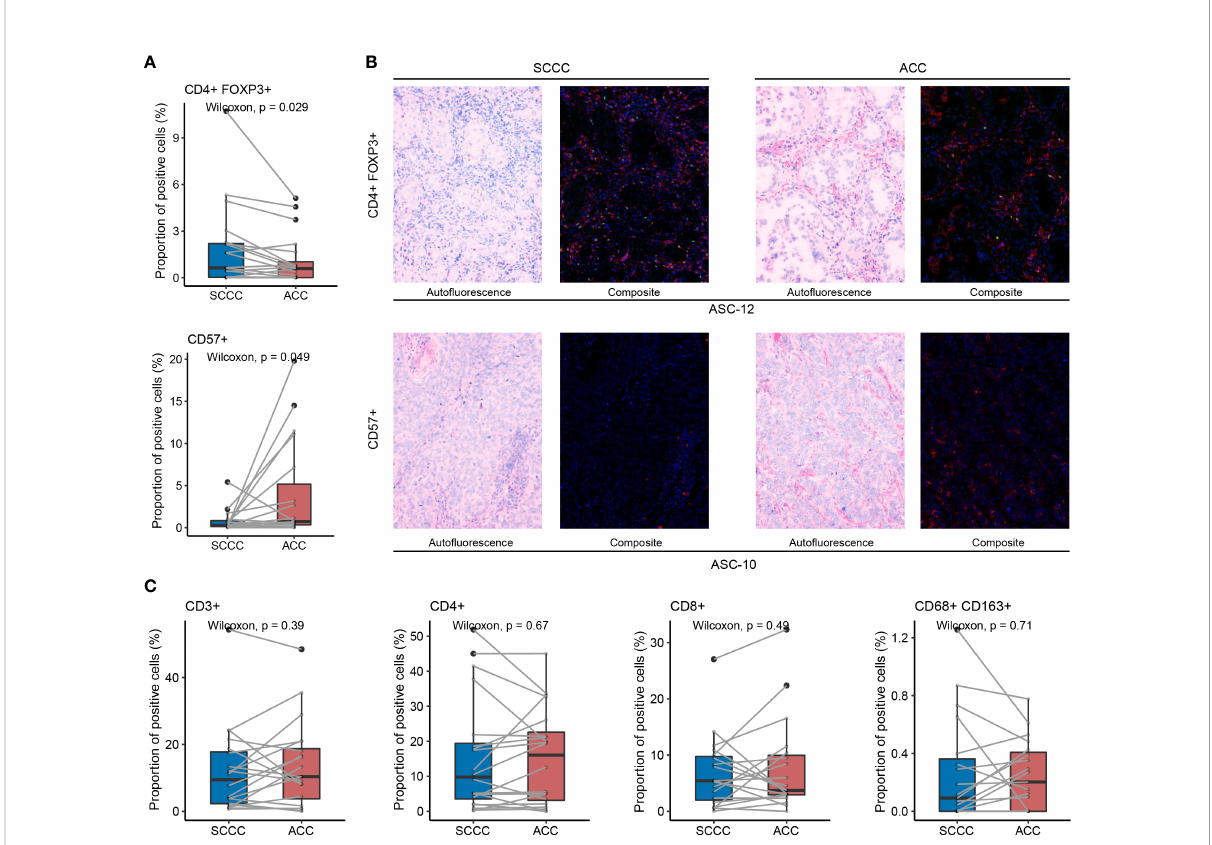
FIGURE 3 Tumor-in fi ltrating lymphocytes (TILs) status in lung adenosquamous carcinoma (ASC) evaluated by multiple immuno fl uorescences. (A) CD4 + FOXP3 + T reg and CD57 + natural killer (NK) cell in fi ltration is re fl ected by their proportions in the total region of squamous cell carcinoma components (SCCCs) and adenocarcinoma components (ACCs). SCCCs reveal enhanced CD4 + FOXP3 + T reg and impaired CD57 + NK cell in fi ltration compared with ACCs. (B) One case of typical CD4 + (green) FOXP3 + (red) T reg in fi ltration and another of typical CD57 + NK cell in fi ltration using multiple immuno fl uorescences. (C) Comparable in fi ltration of CD3 + , CD4 + , CD8 + TILs, and CD68 + CD163 + M2 tumor- associated macrophages between SCCCs and